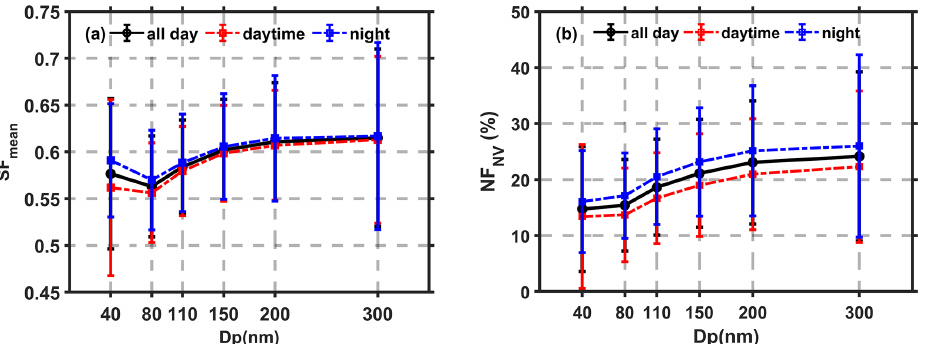
Figure 7. (a) Size-resolved ensemble mean shrink factors (SF mean ) and (b) size-resolved number fractions of nonvolatile particles (NF NV ) during the 24h day (solid black lines), during daytime (dotted red lines) and during nighttime (dotted blue lines). The error bars denote standard deviations.